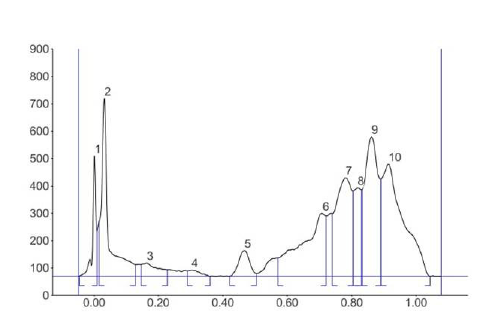
Fig. 18. Soxhalation fruit extract, HPTLC chromatogram of ethyl acetate fruit extract of M. cymbalaria